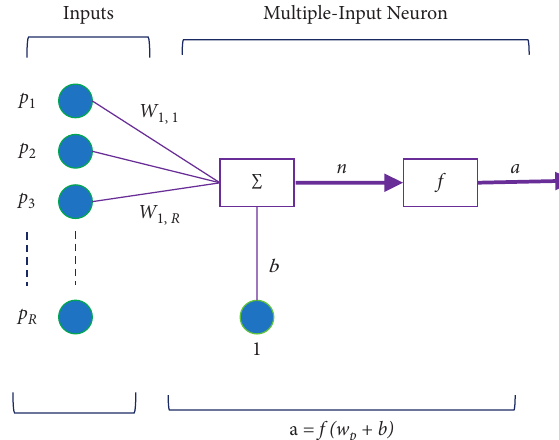
Figure 4: Multilayer perceptron